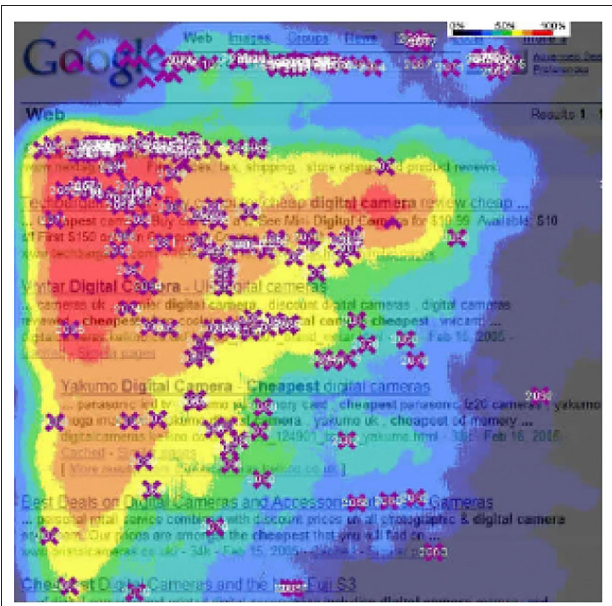
FIGURE 2 | Heatmap from real usage data of how users navigate a simple search result page, the attention is focused on a top-left golden triangle and progressively decreases moving to the right and the bottom ( Chierichetti et al., 2011